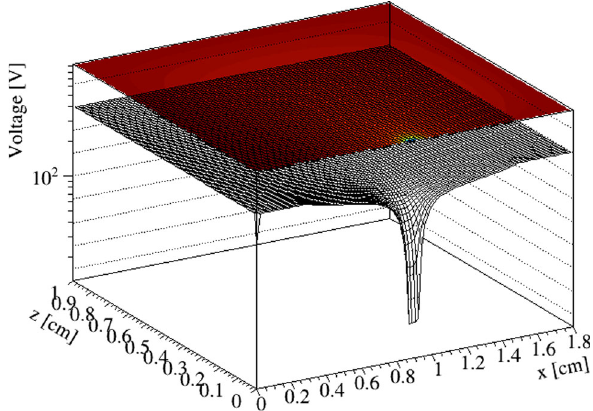
Fig. 13 The potential field distribution in the detector when a positive voltage of 400 V was applied to the outside surface